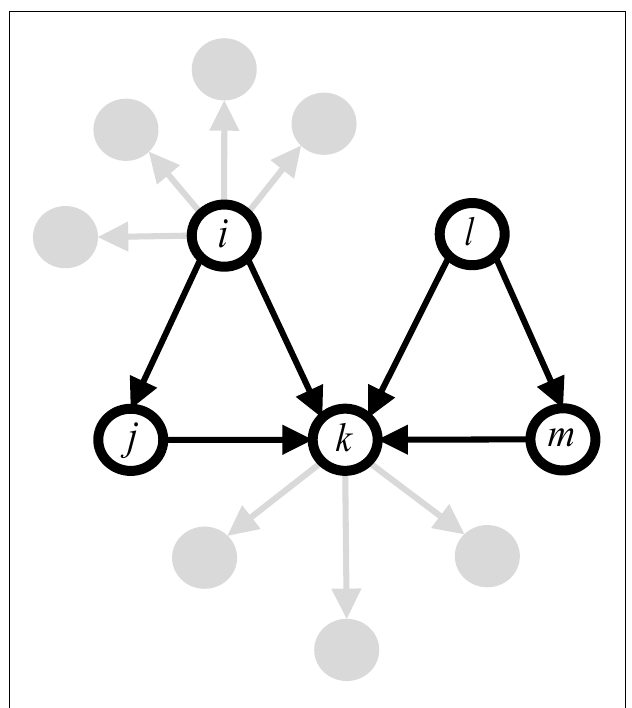
FIGURE 1 | Genes of feed-forward loops (open circles) may be connected by the participation of common